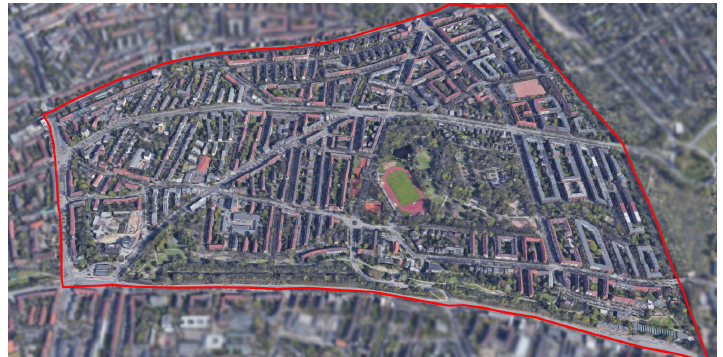
Figure 12. Visualisation of a district in Hamburg Hamm using an underlying image from Google Maps [139]. Image adapted in order to highlight the considered urban